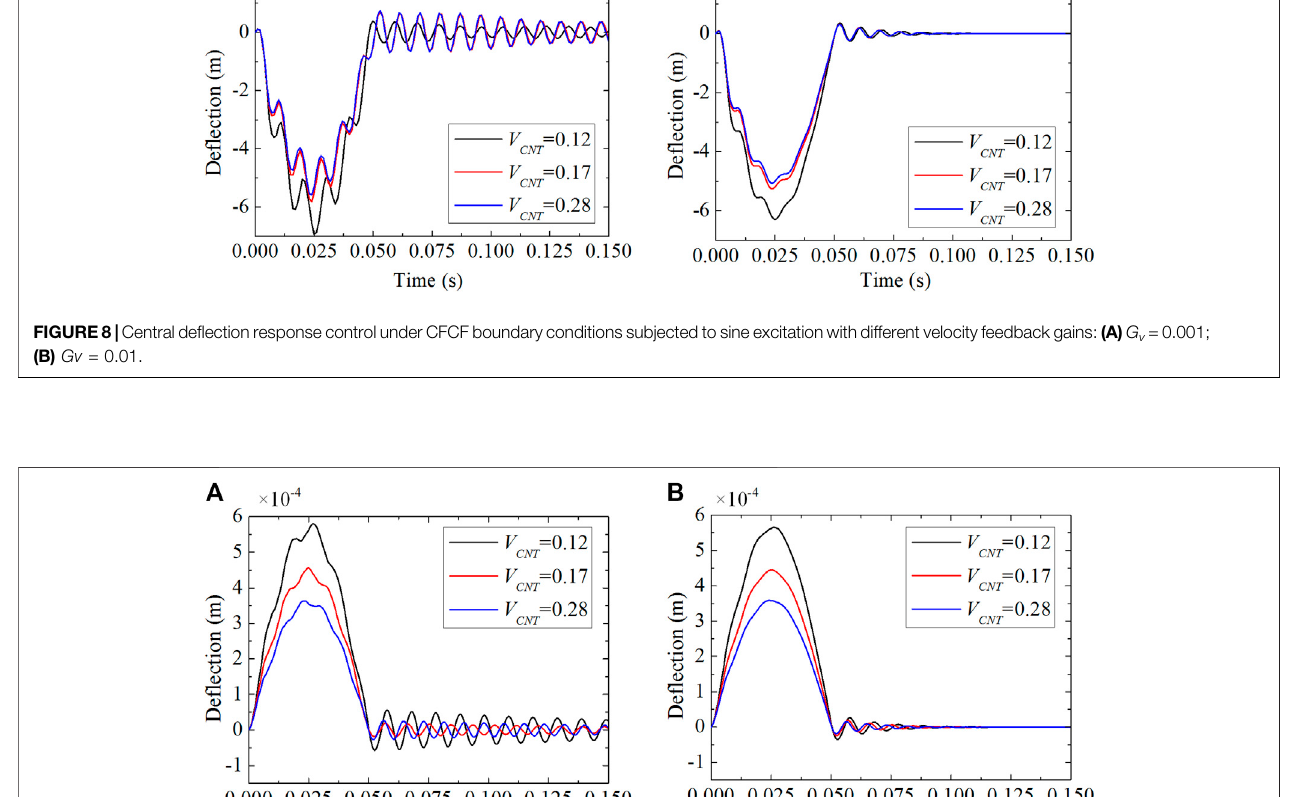
(cid:2) 0 . 141 and η (cid:2) 1 . 585 for V (cid:2) 0 . 28 CNT 1 2 is equal to 0 . 7 η , which is obtained 3 2